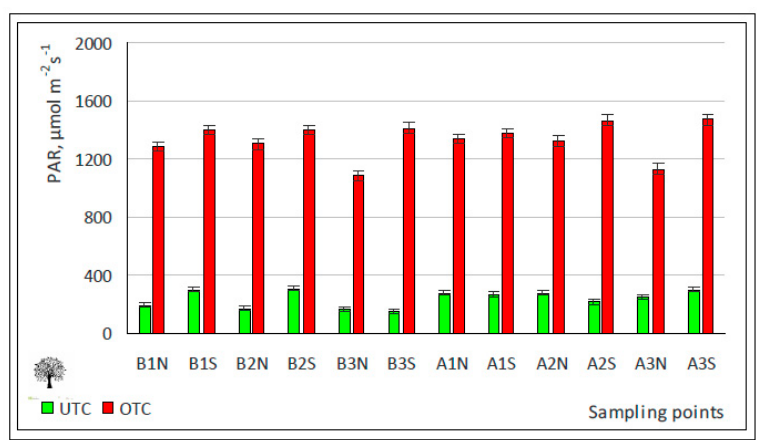
Figure 15. Photosynthetically active radiation (PAR) in April 2016, outside tree canopy (OTC) and under tree canopy